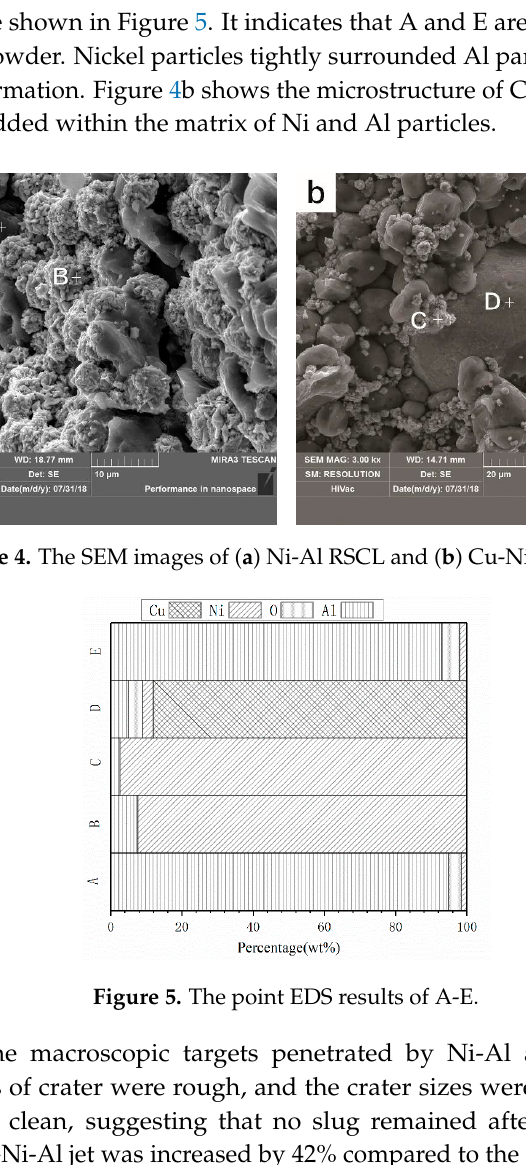
Figure 3. The schematic of the penetration experiments.